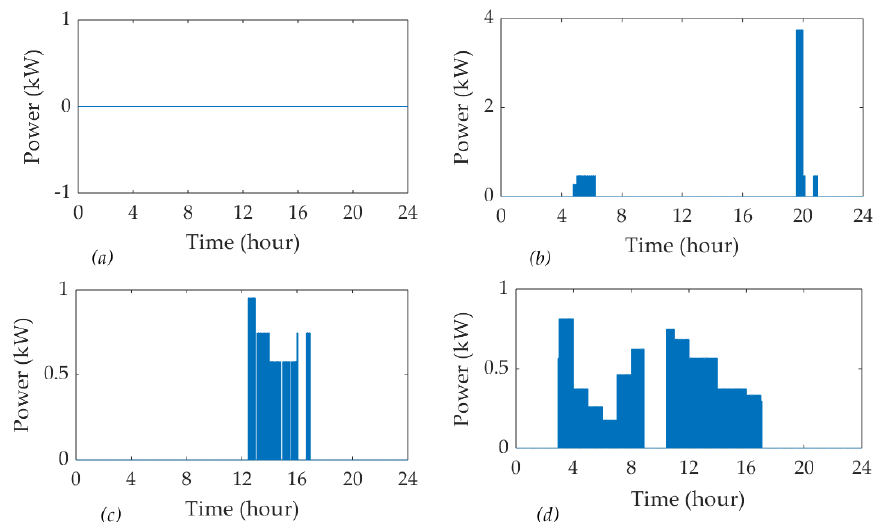
Figure 12. Smart grid fed-in power in the four days. ( a ) spring day; ( b ) summer day; ( c ) autumn day; ( d ) winter day.